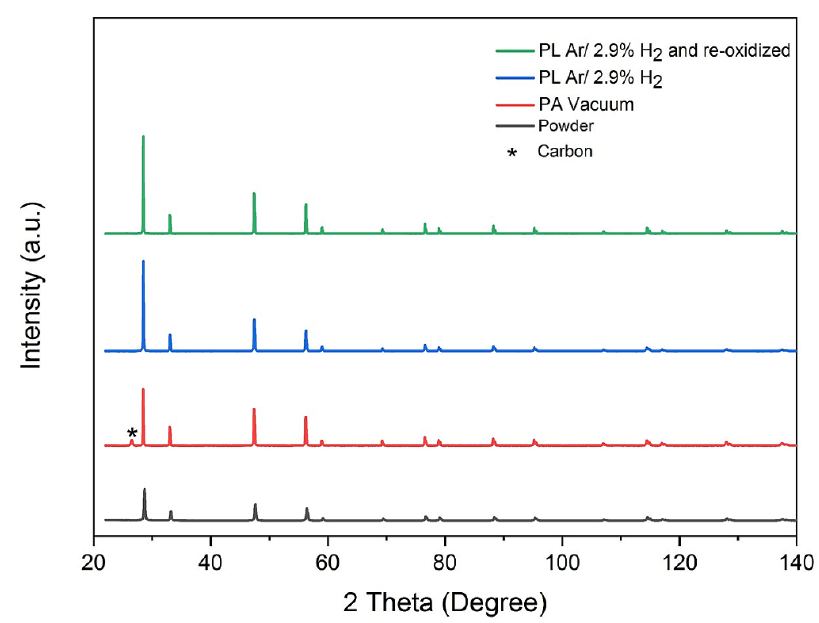
Figure 10. XRD patterns for GDC10-HP samples after FAST/SPS sintering in different atmospheres.